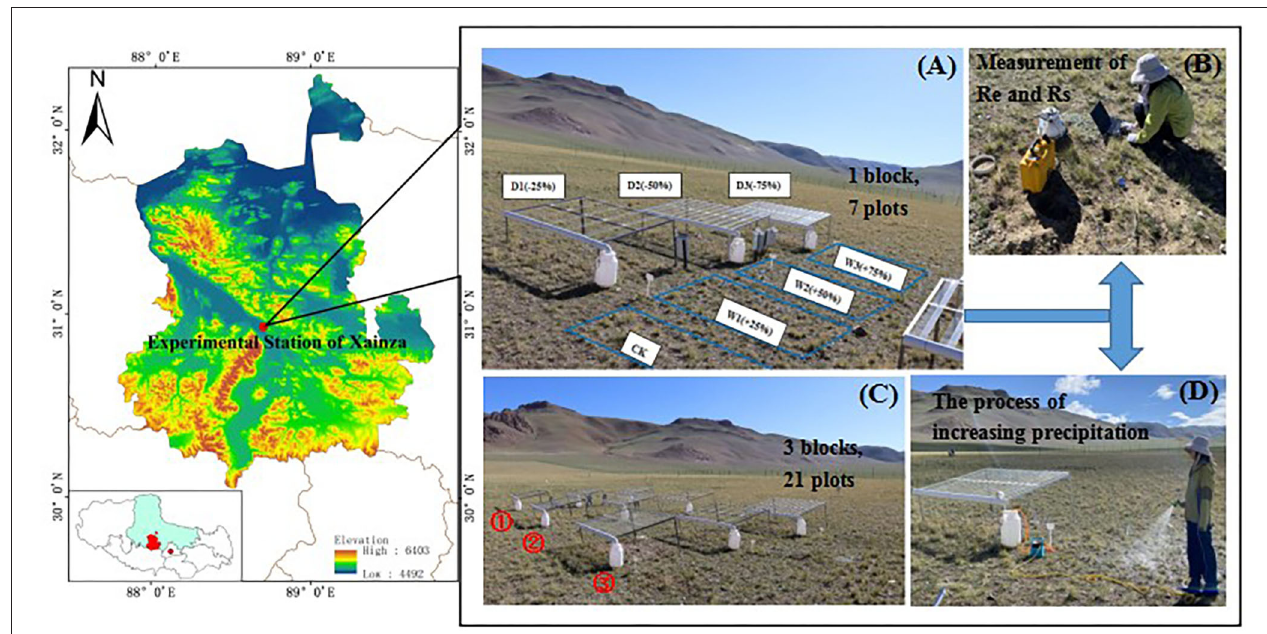
FIGURE 1 | Location of the study area and design of the experiment. (A) Diagram of the seven precipitation treatments; (B) ecosystem respiration (Re) and soil respiration (Rs) measurements; (C) a complete experimental site with three blocks and 21 plots; (D) the process of increasing precipitation in the